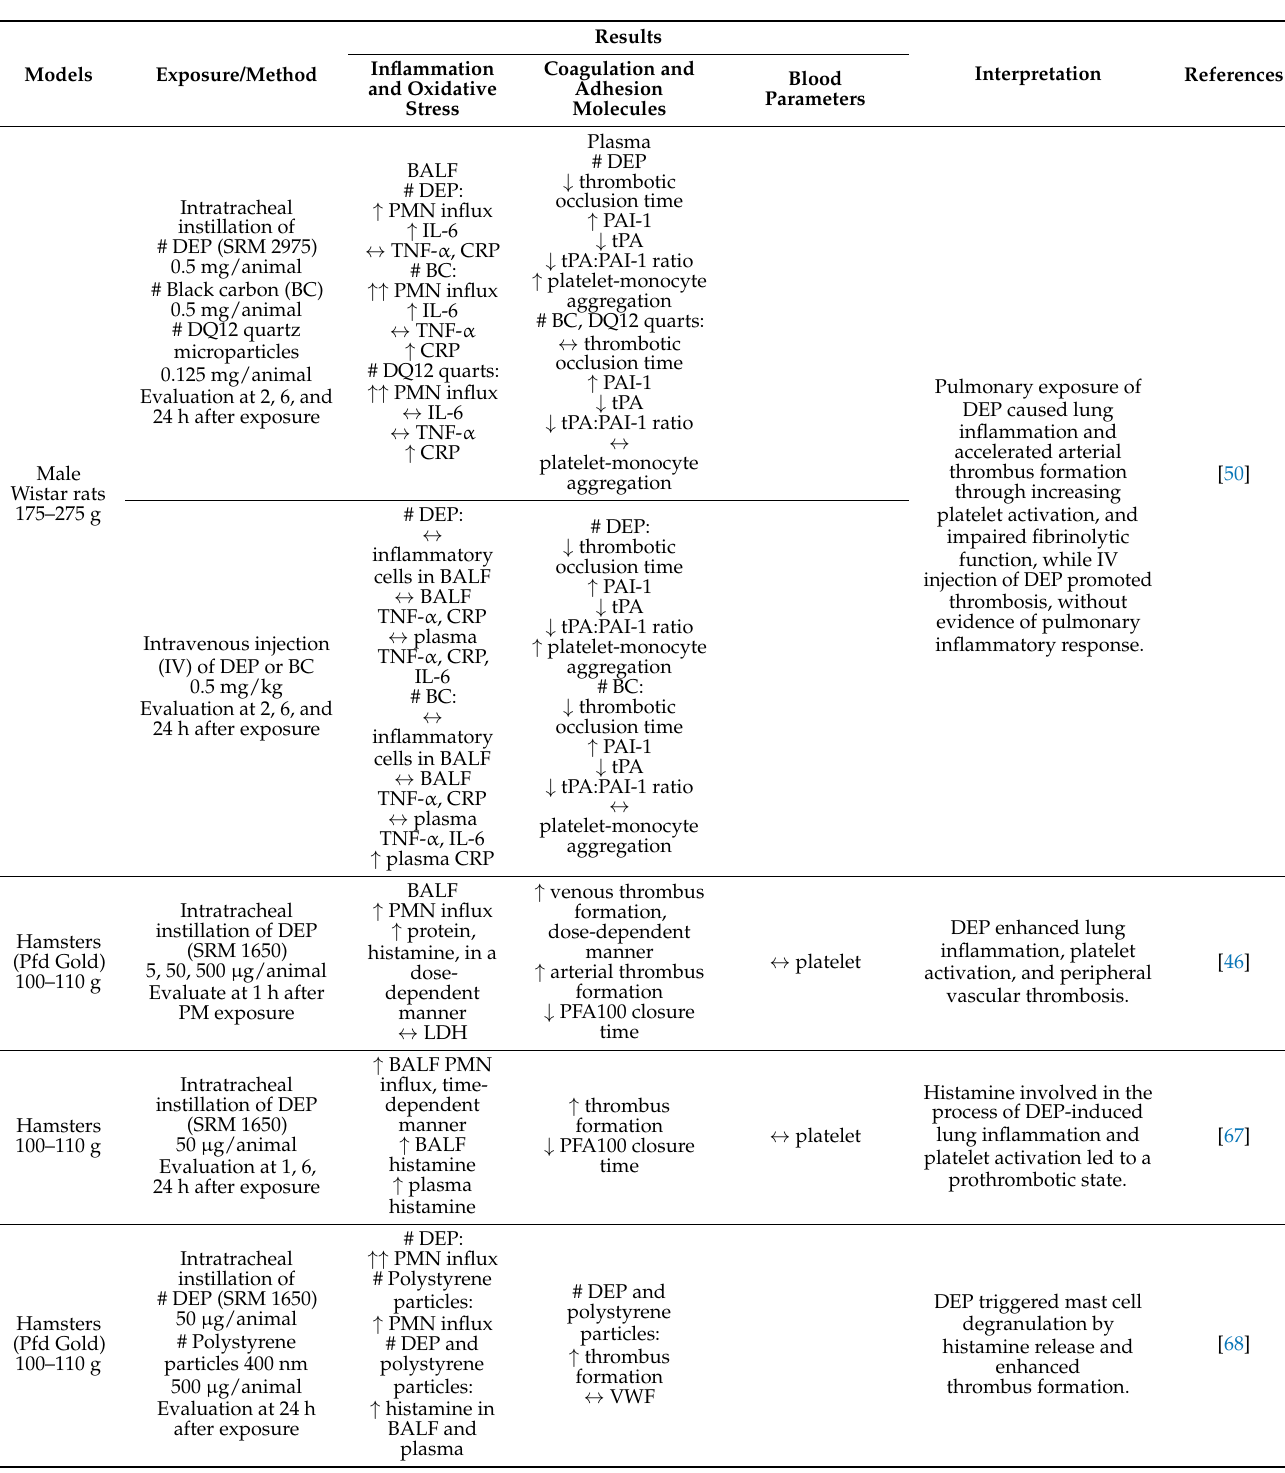
Table 3. The effects of DEP on inflammation, oxidative stress, blood parameters, and hemostatic changes: Evidence from in vivo